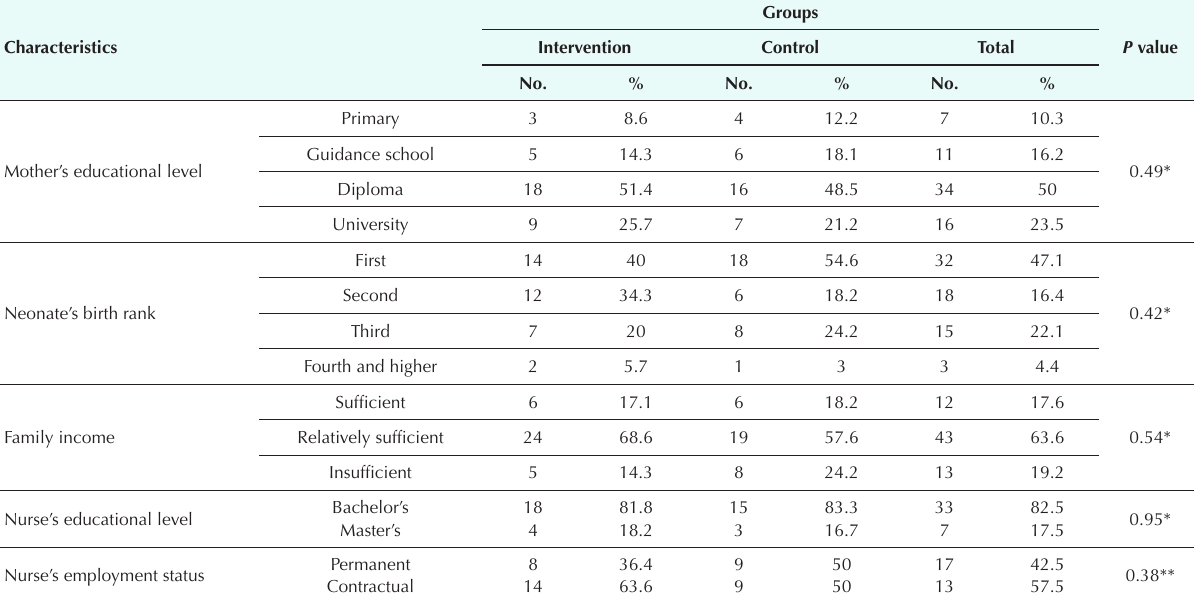
Table 2. The demographic characteristics of participating nurses and mothers